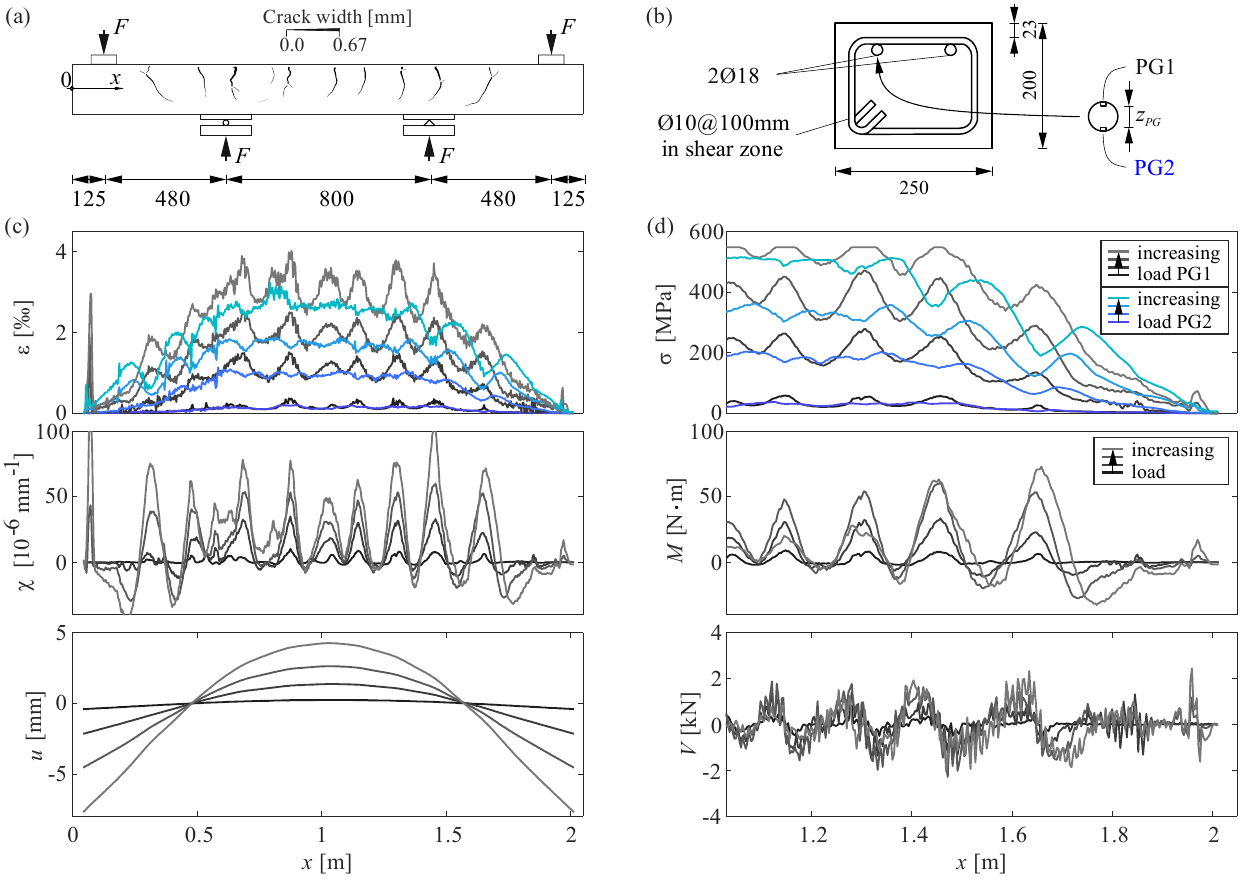
Figure 12. Fibre optical strain measurements on a flexural reinforcing bar of specimen Nn: ( a ) ge- ometry and test setup with crack pattern and crack widths obtained with ACDM at the load F = 58 kN—dimensions in [mm]; ( b ) cross-section with instrumented reinforcing bar with two vertically aligned polyimide-coated fibre optical sensors glued inside a 1 × 1 mm 2 groove (PG1 and PG2); ( c ) strains of both sensors and distribution of bar curvature and deflections derived from these strains over the entire length; and ( d ) calculated bar stresses from both FOS, and distribution of bending moment and shear force in the reinforcing bar over the right beam half.